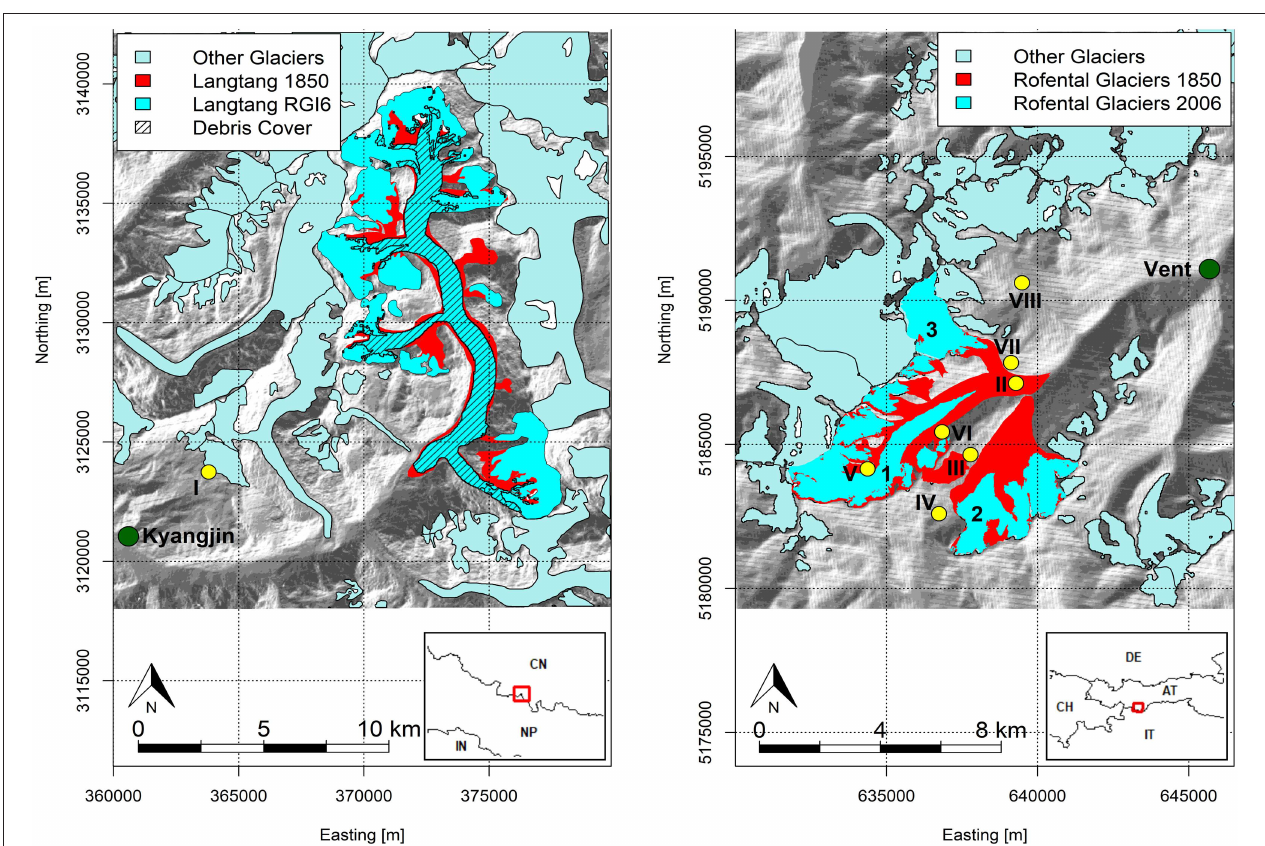
FIGURE 1 | The Langtang Glacier ( left ) and Hintereisferner ( right ) with the glacier outlines of 1850 (turquoise), the current glacier outlines (red), and the current debris extents (black stripes; Langtang Glacier). The other glaciers (light blue) and the locations of the primary and secondary meteorological stations (green and yellow dots, respectively) in the region are also shown. The numbers 1, 2, and 3 denote the locations of the Hintereisferner, Hochjochferner, and Kesselwandferner, respectively. The numbers I–VIII denote the locations of the Yala base camp (I), Hochjochhospiz (II), Latschbloder (III), Bella Vista (IV), Hintereis (V), Rofenberg (VI), Proviantdepot (VII), and Vernagtbrücke (VIII) stations. Source of the glacier outlines are the Randolph Glacier Inventory v6 ( Pfeffer et al., 2014) and the Austrian glacier inventories (Abermann et al., 2009; Fischer et al., 2015). The debris extents are obtained from Kraaijenbrink et al.